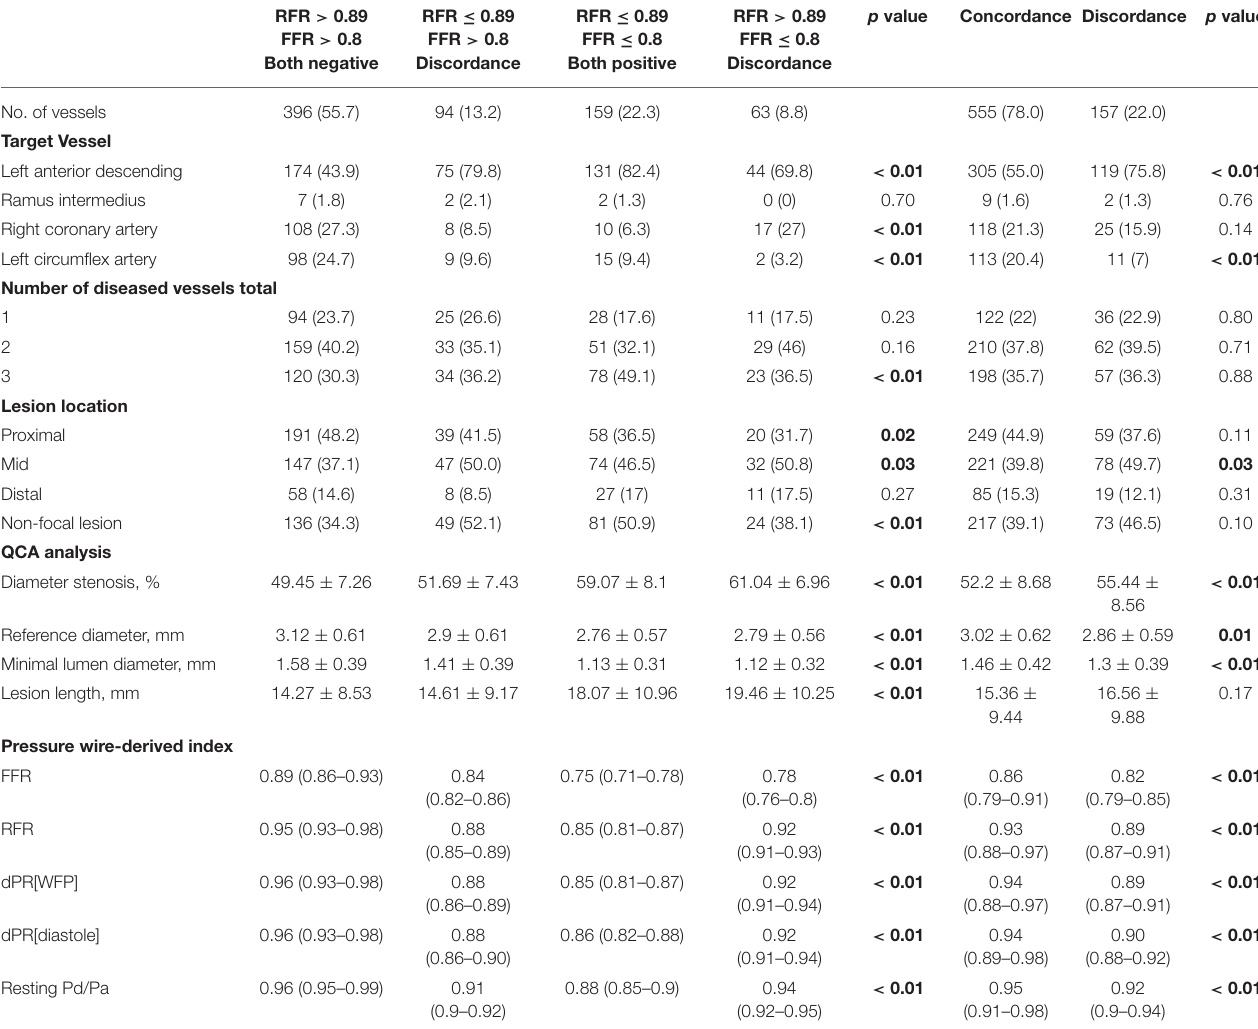
TABLE 3B | Vessel and lesion characteristics between concordant and discordant cases of RFR and